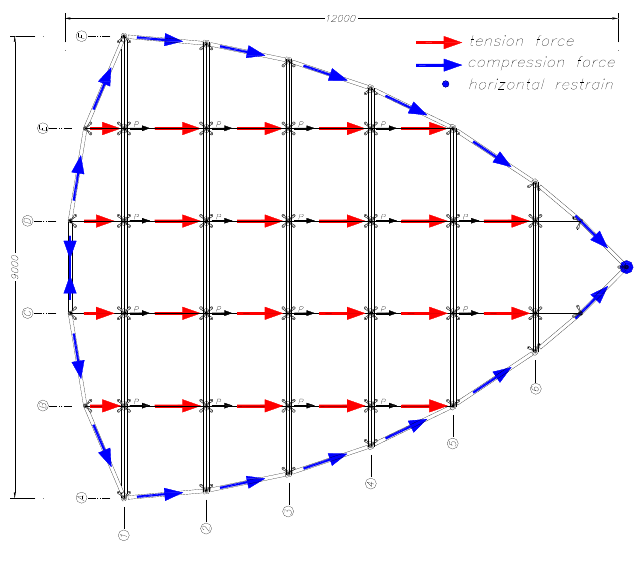
Figure 5: Horizontal load path.